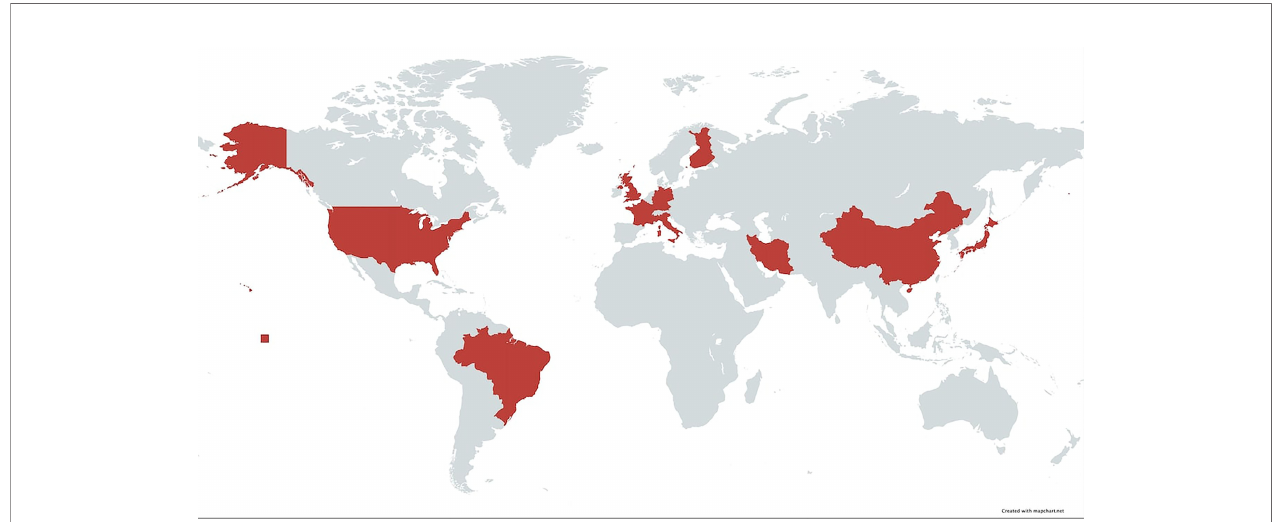
FIGURE 4 | Map of the world highlighting area in which HLA studies have been done on native populations. In these countries, patients with pemphigoid diseases had a strong association with HLA-DQ b